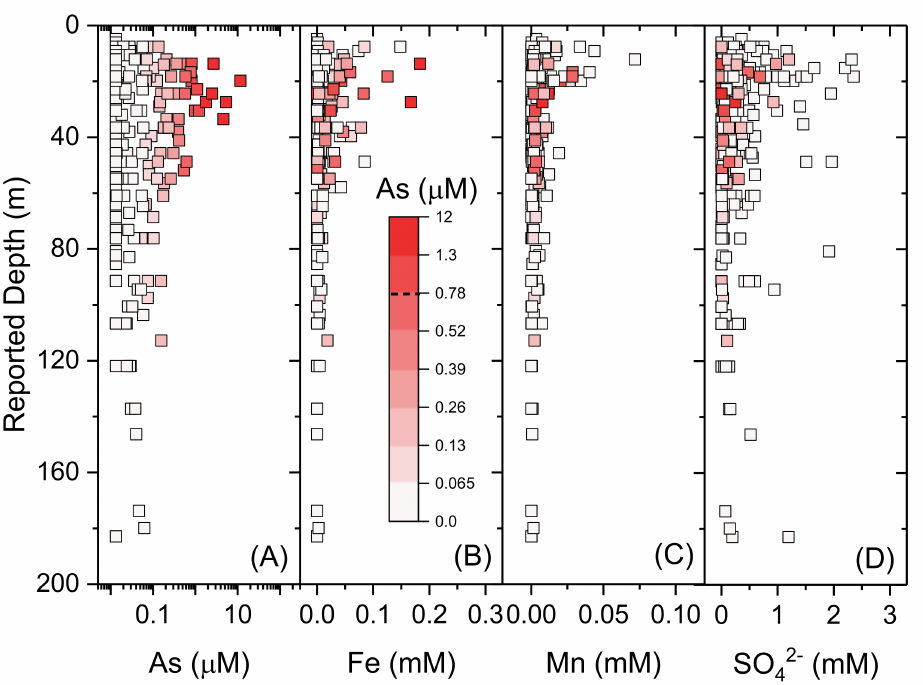
Figure 10. Depth profiles of ( A ) As (log scale), ( B ) Fe, ( C ) Mn and ( D ) SO 42 − ; colour scale indicates As concentrations with WHO provisional guideline [4] of 0.13 µ M (10 µ g.L − 1 ). Samples with measured concentrations below detection for a particular analyte are shown as maximum concentration at method detection